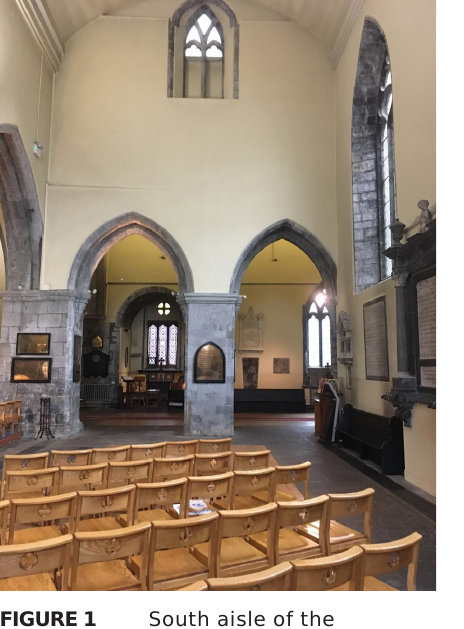
View into the Chapel of the Blessed Sacrament from the